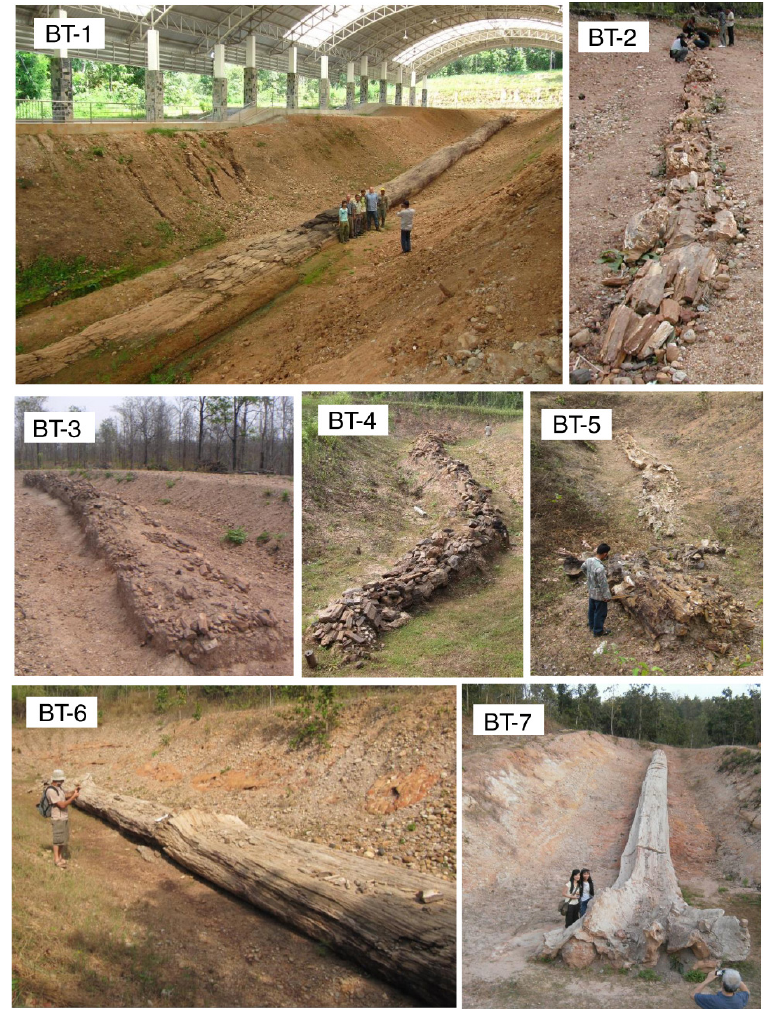
Figure 2. Tak fossil logs. BT-1 is shown in a newly-constructed permanent shelter. This log is relatively well preserved. Logs 2–5 are highly fragmented.Logs 6, 7 have fractured areas, but are mostly intact.